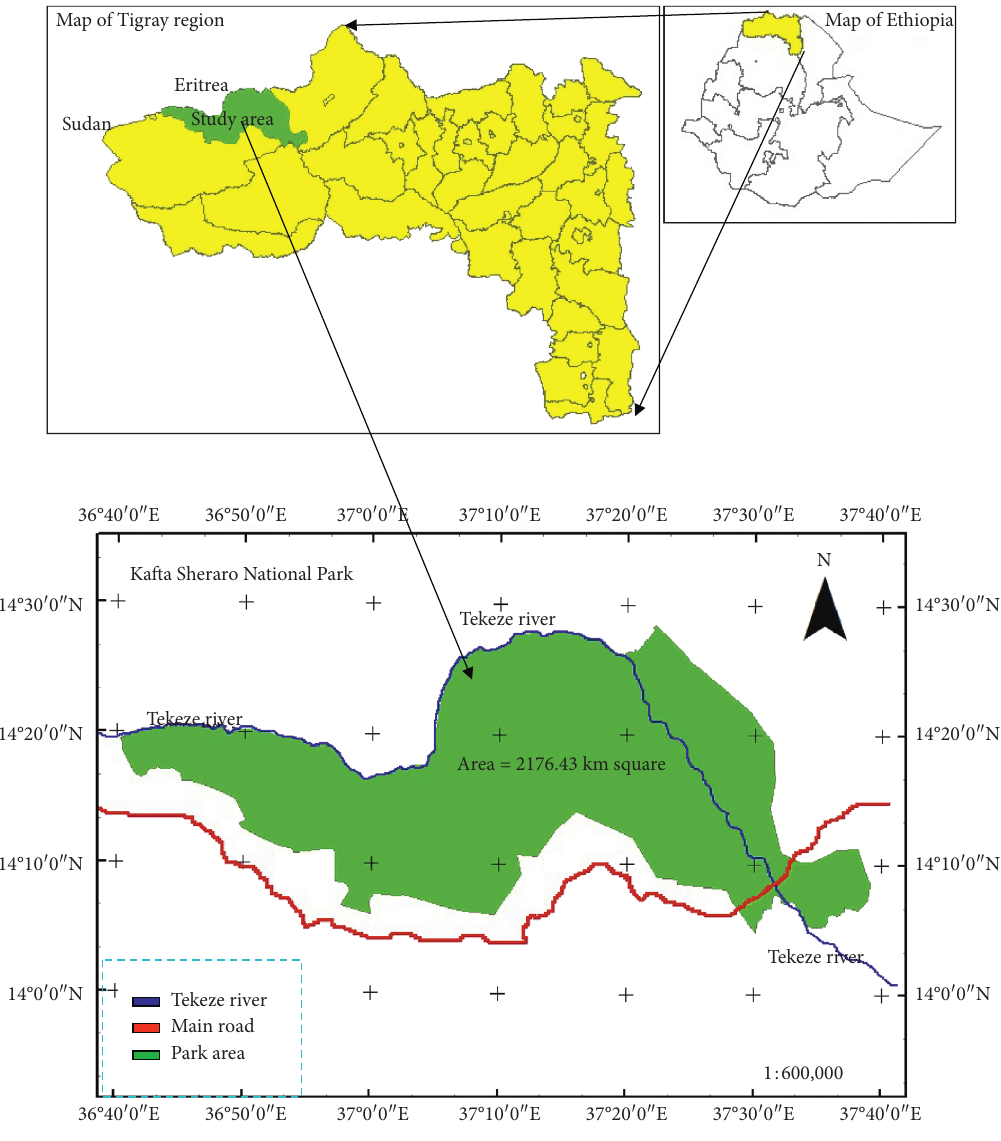
Figure 1: Location of the study site.